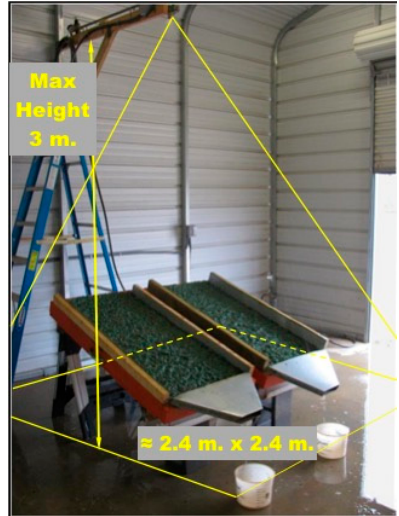
Figure 1. Illustration of rainfall simulator and test plots.